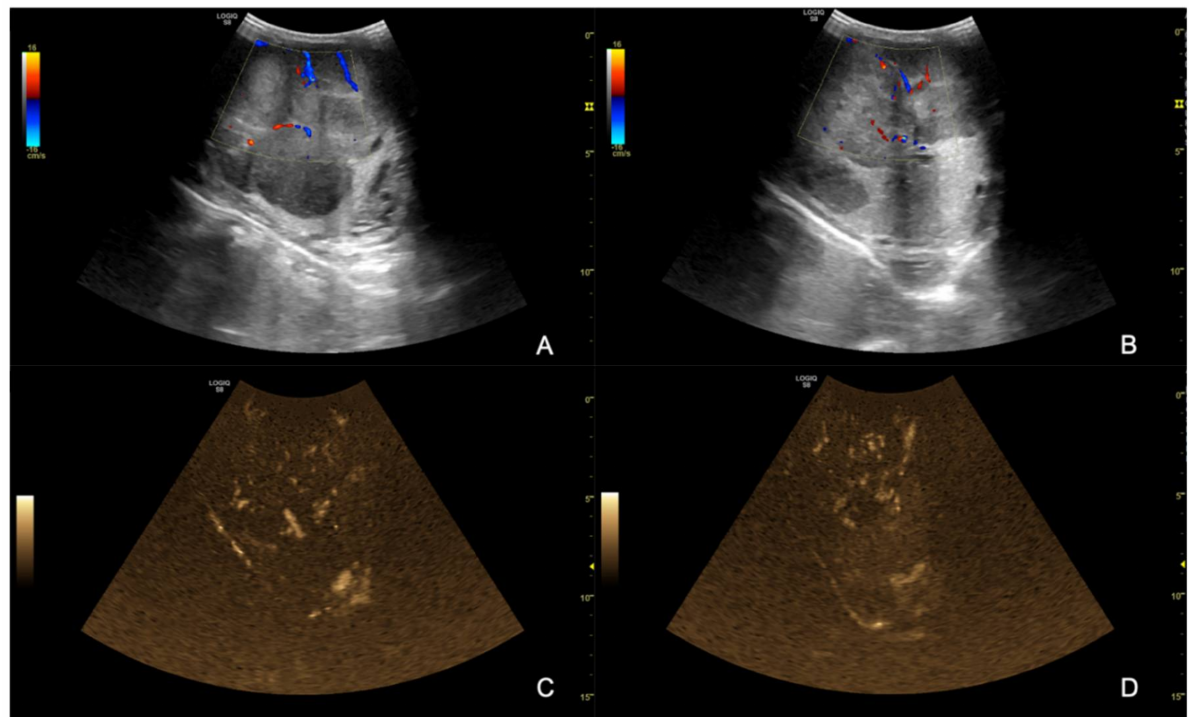
Figure 4. B-blow images ( A , B ) and Color Doppler ( C , D ) of the left testicle; note the heterogeneous vascular lesion distribution appearing as both peripheral and central in different portions of the same